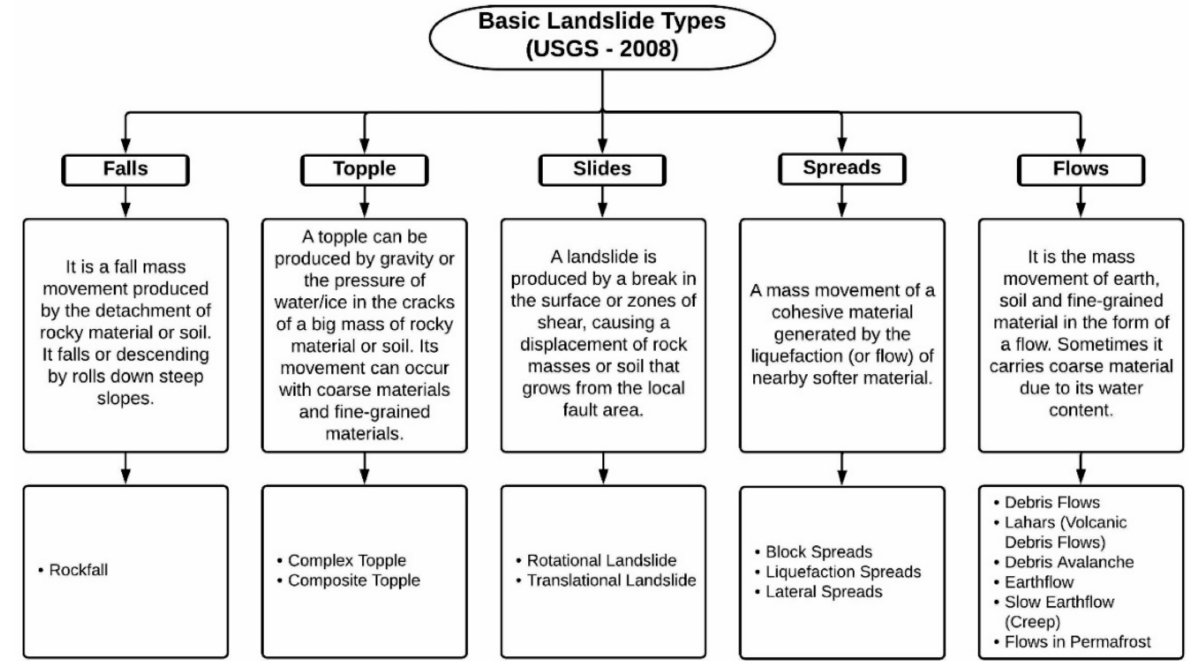
Figure 1. Classification scheme based on the literature review of the USGS landslide manual. Source: